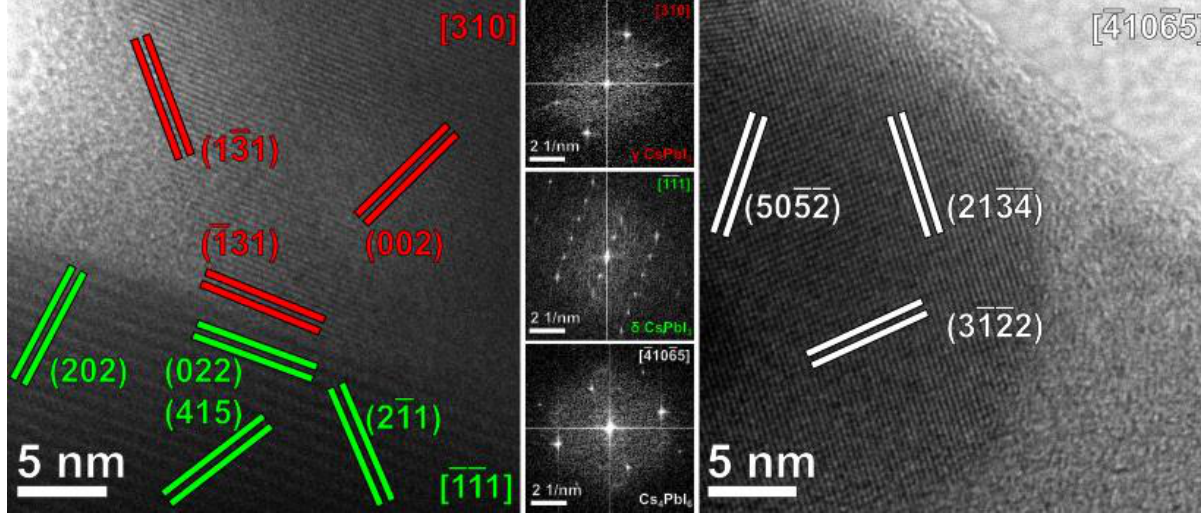
Figure 10. Representative HRTEM images of the CPI3-10 h sample. Lattice planes of γ-CsPbI 3 , δ-CsPbI 3 and Cs 4 PbI 6 are indicated in red, green and white, respectively. The 2D-FFT diffractograms used to calculate the orientations of each domain are reported in the central column.